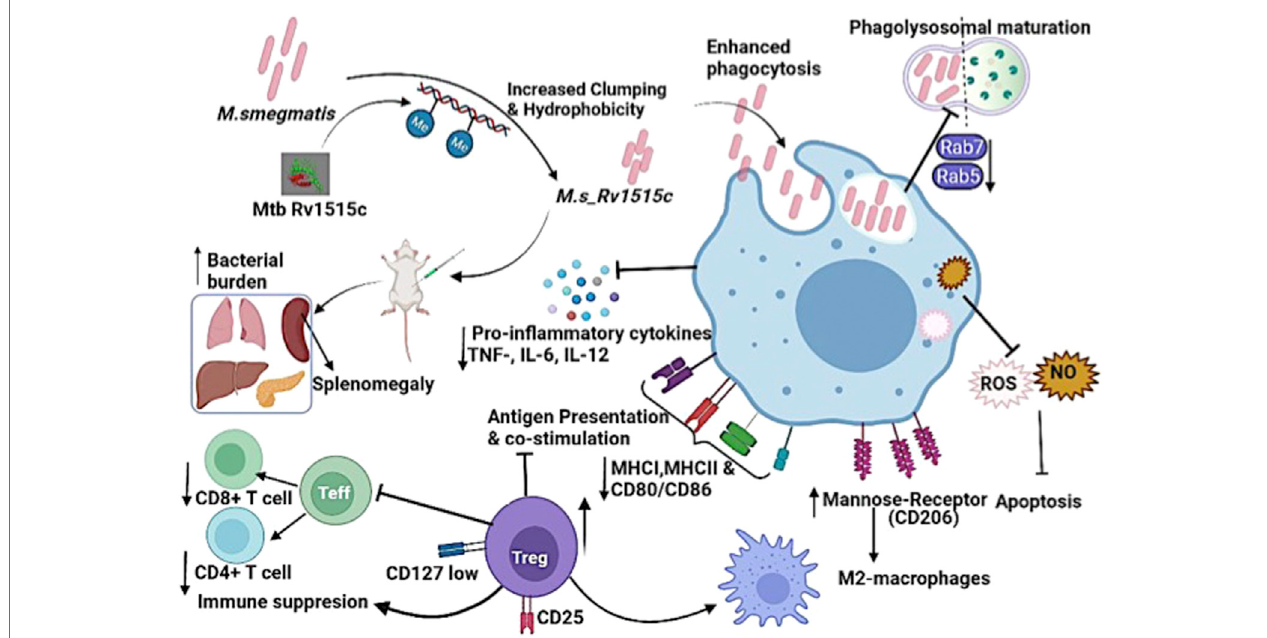
FIGURE11 | Model displaying the distinctrole of M. tb methyltransferase Rv1515c in host-immune modulation: Knock-in of M. tb Rv1515c gene in M. smegmatis ( M.s _Rv1515c)altered celldimension,morphologyandcellsurfacehydrophobicity.Therecombinant M.s _Rv1515cexpressingRv1515cproteinismorevirulentandis phagocytosed by the macrophage. M. s _Rv1515c exhibits higher survival within the macrophage due to its ability to escape phagolysosomal fusion. The early and late phagolysosomalmarkersRab5andRab7,respectivelyisdownregulated.Rv1515cdampenstheproductionofreactiveoxygenspecies(ROS)andnitricoxide(NO) within the macrophage and suppresses apoptosis, which favors mycobacterial persistence in the macrophages. Rv1515c aids the bacteria to resist immune response. Rv1515c suppresses themolecules involvedinantigenpresentation (MHCI, MHCII)and co-stimulation(CD80 and CD86). Rv1515csuppresses effector Tcellresponse via upregulation of immunosuppressive Tregs cells which may favour bacterial